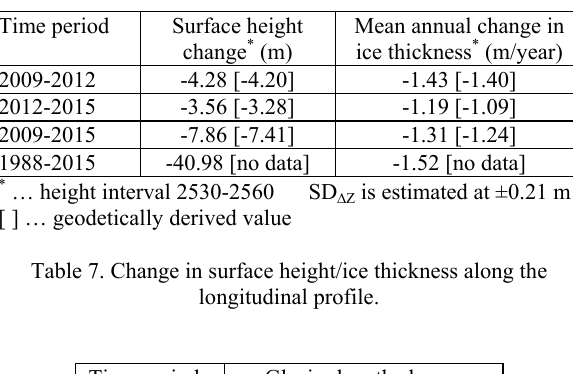
Table 1. Bundle adjustment with Agisoft PhotoScan (4 photographs, original image data).